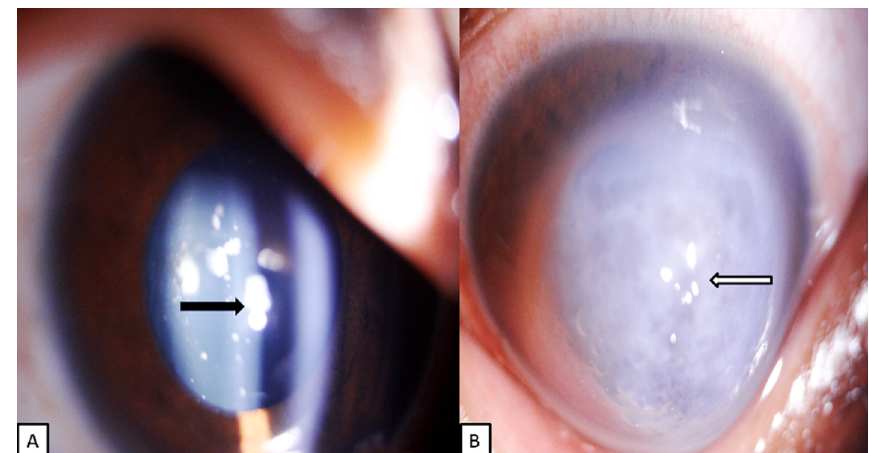
Figure 1: A: Image of the patient’s right eye depicting congenital cerulean (blue) dot cataract. B: Image of the patient’s left eye depicting acute corneal